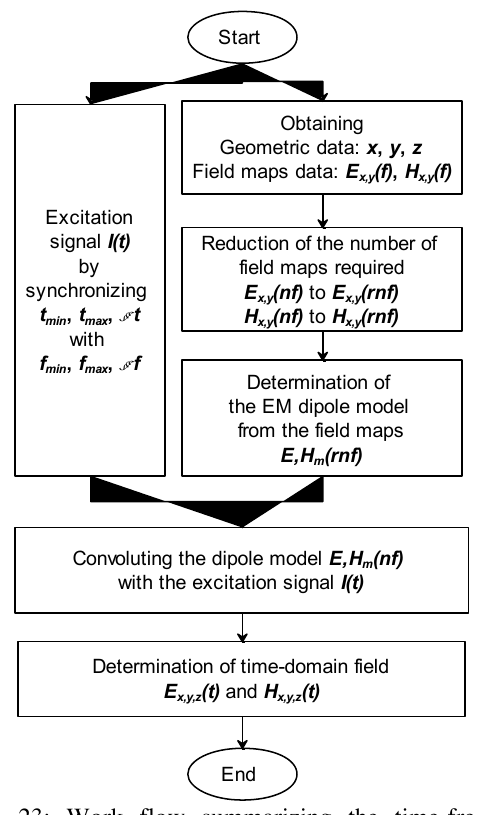
Figure 23: Work flow summarizing the time-frequency modelling method